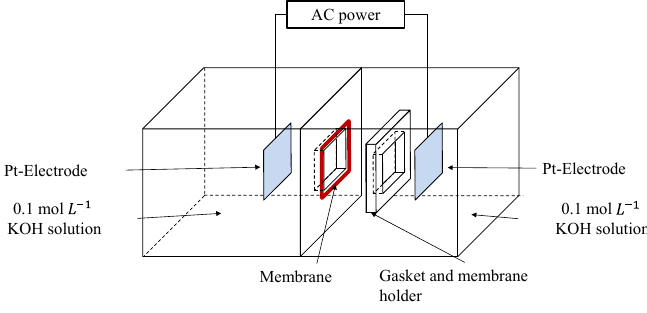
Figure 2. Scheme of the conductivity measurement cell. The effective area of the cell is 4 cm 2